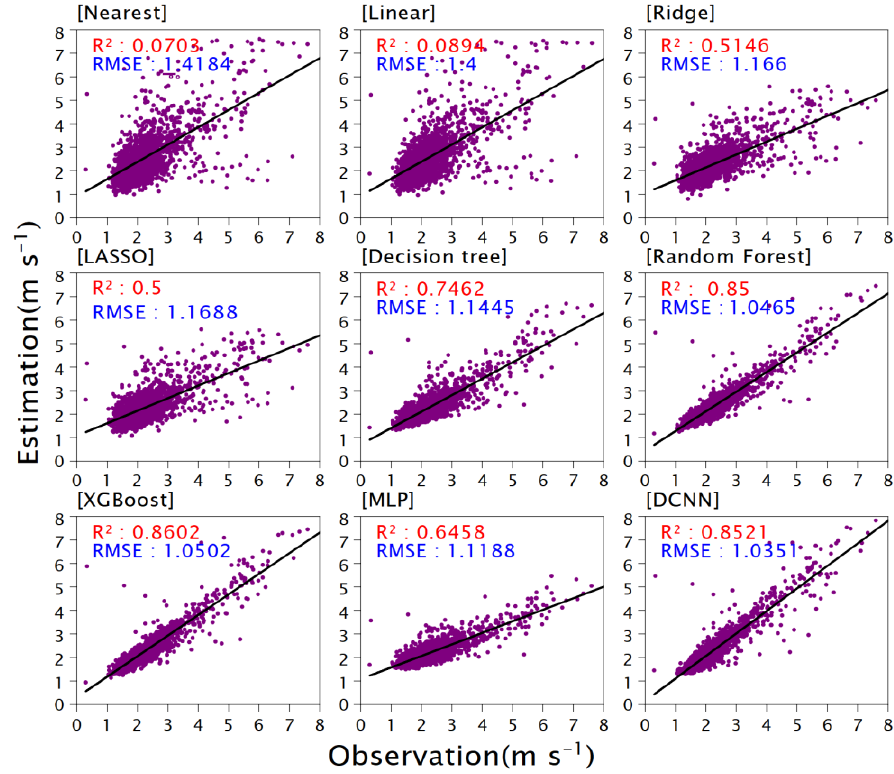
Figure 8. Correlation analysis of observed summer wind speeds and those predicted by each method.